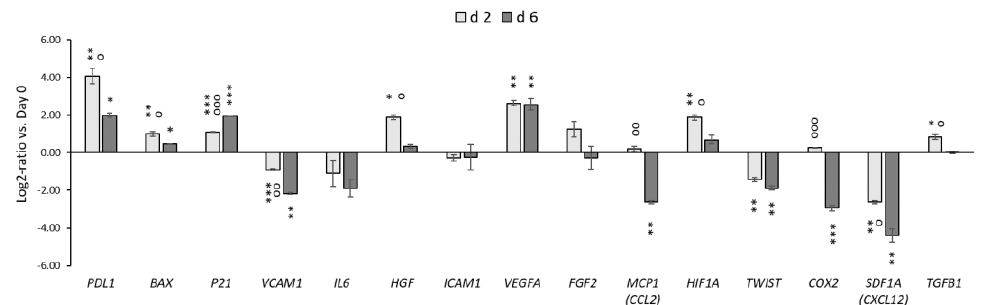
Figure 3. The effect of hypothermic storage on the relative gene expression of selected genes in WJ-MSCs cultured within 3D HyaloFast ® , assessed by qPCR ( n = 4) . The graph shows the log2-fold changes of the ΔΔCt values of the indicated genes in comparison to day 0. The data are presented as Mean ± SEM. *, **, *** — the data are significantly different compared to non-stored cells (*** — p < 0.001; ** — p < 0.01; * — p < 0.05); °, °°, °°° — the data are significantly different between the d 2 group and the d 6 group (°°° — p < 0.001; °° — p < 0.01; ° — p < 0.05).